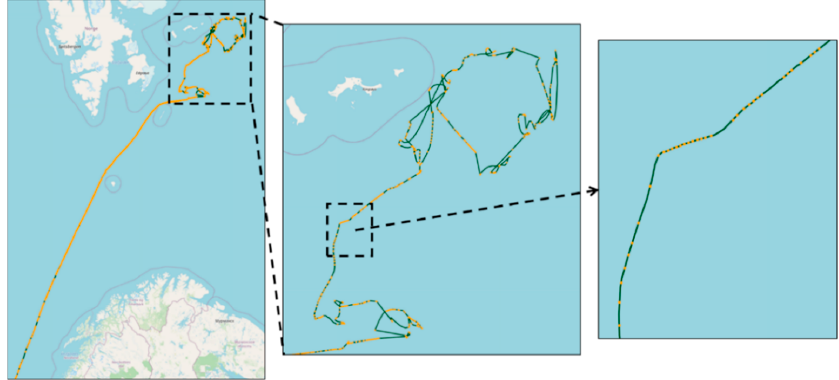
Figure 11. Trajectory reconstruction results with MMSI of 218832000.